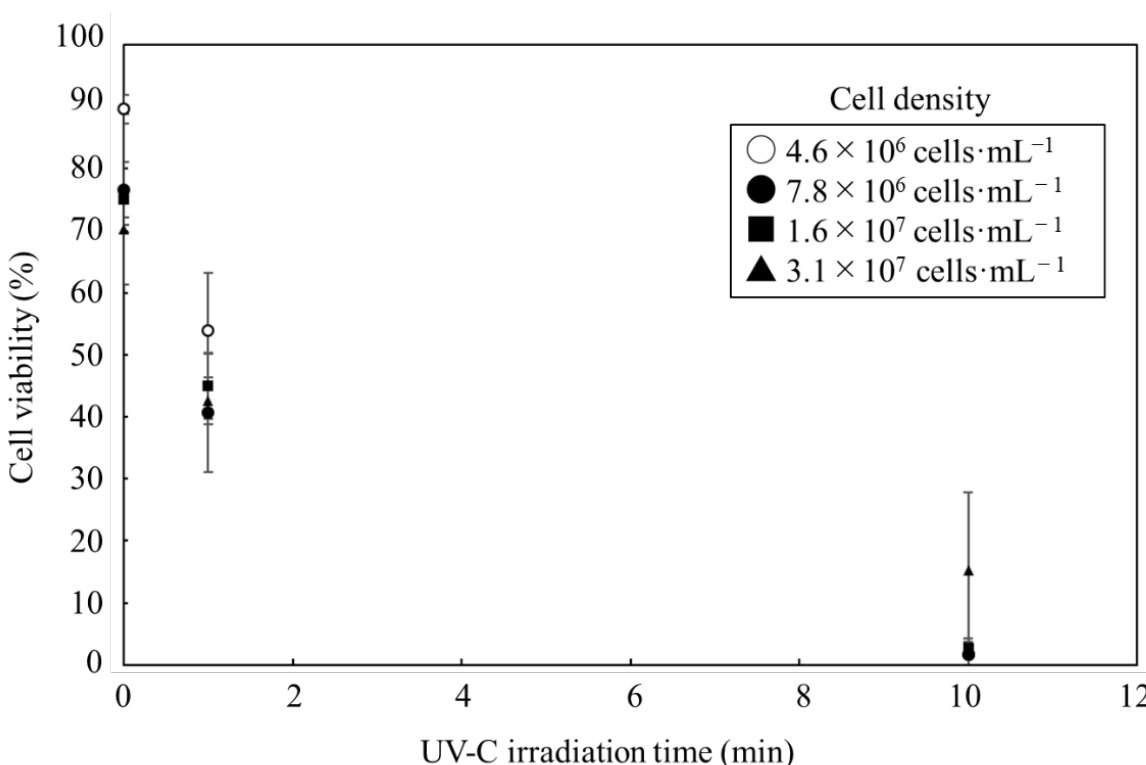
Figure 1. Effect of UV-C irradiation for cell sterilization. Cell viability of C. reinhardtii was evaluated in each cell density after UV-C irradiation. Cells were irradiated with a UV irradiator (1.209 mW·cm −2 ) in 5.0 mm depth of 2.0 mL of PBS on a 33 mm glass petri dish. The cell densities were shown as cycle 4.6 × 10 6 cells·mL −1 , diamond 7.8 × 10 6 cells·mL −1 , square 1.6 × 10 7 cells·mL −1 and tri- angle 3.1 × 10 7 cells·mL −1 . Error bars indicate the standard deviation (SD) of three replicate experi- ments (n = 3).